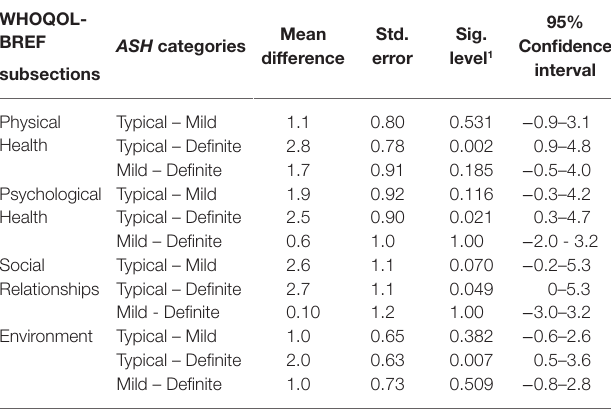
TABLE 3 | Results of follow-up MANOVA with Bonferroni adjustment of WHOQOL-BREF domains by ASH categories. WHOQOL-